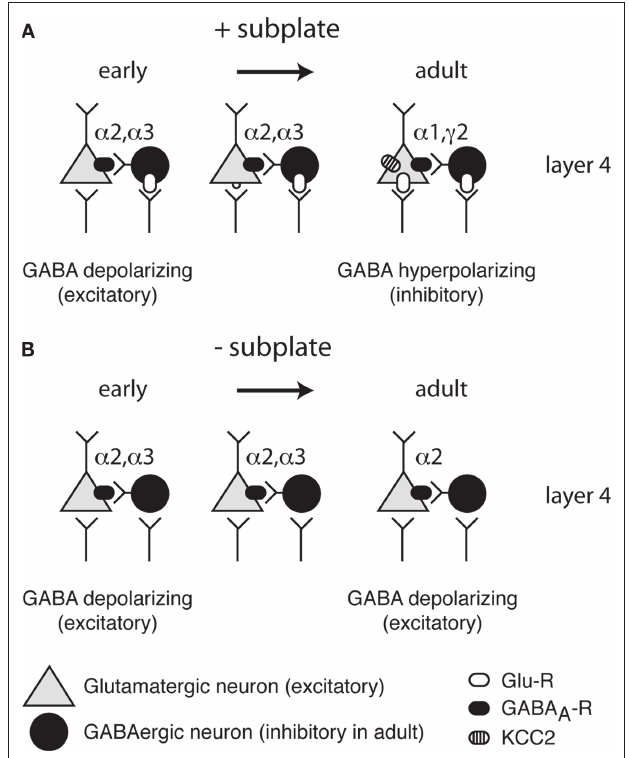
FIGURE 2 | Maturation of GABA(A)ergic circuitry. (A) Normal development with subplate present. Early in development (left) GABAergic inputs to neurons are depolarizing due to the lack of KCC2. As development progresses (middle) glutamatergic synapses appear and further depolarize neurons. Glutamatergic synapses strengthen and at a certain point in development a critical threshold of depolarization is reached (right) and KCC2 levels are increased, rendering GABA hyperpolarizing (inhibitory). In addition, mature GABAergic receptor subunits are expressed. (B) Abnormal development with subplate absent. KCC2 levels remain low and immature GABA receptor subunits remain expressed, while levels of mature subunits remain